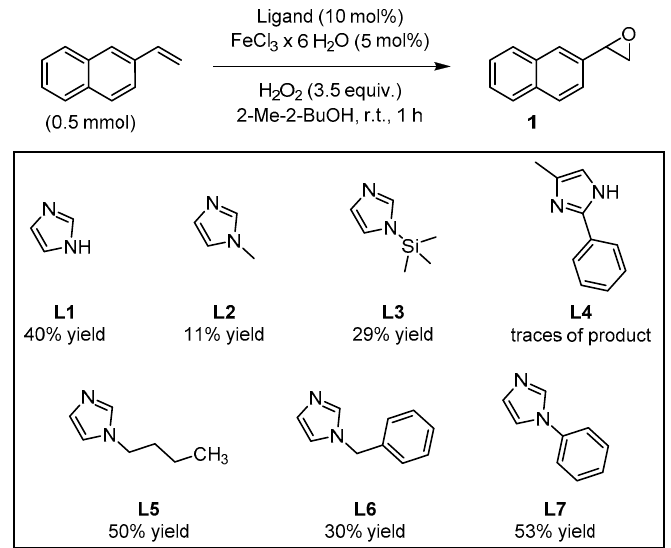
Figure 3. Screening of imidazole-based ligands: yields of the epoxide products were determined via 1 H-NMR using pyrazine as internal standard.